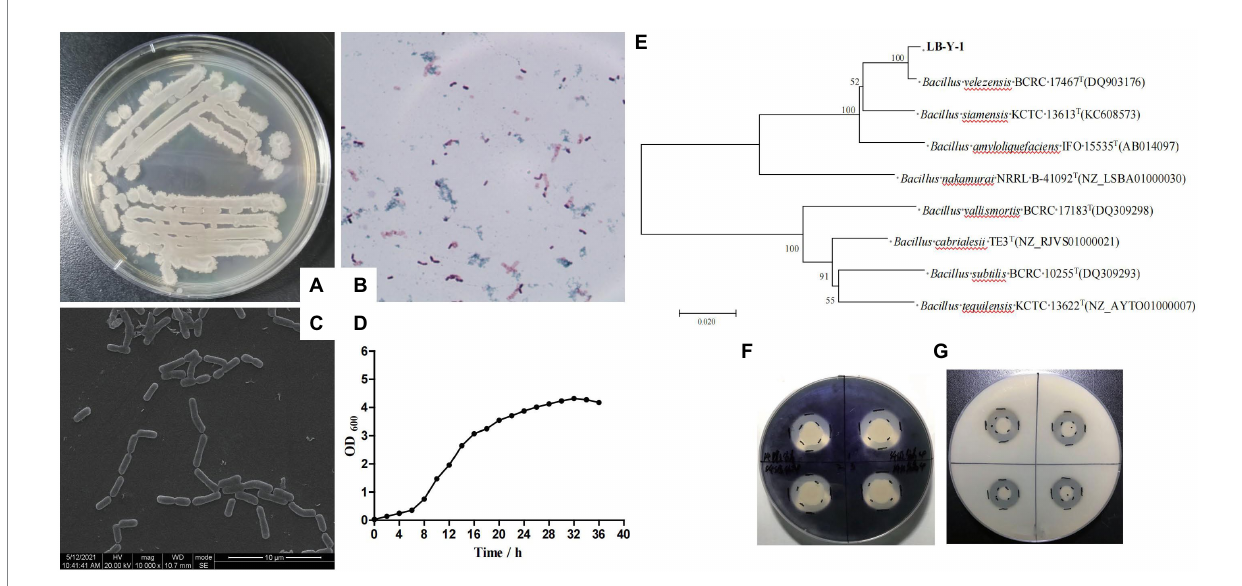
FIGURE 3 Morphological, biochemical, and molecular characteristics of LB-Y-1. (A) Colony morphology. (B) Gram stain showing Gram-positive rod. (C) SEM image of LB-Y-1 showing a small rods morphology, frequently in pairs or short chains (×1,000). (D) The growth curve of LB-Y-1. (E) The phylogenetic tree analysis of LB-Y-1. (F) Starch-degradation ability. (G) Triglyceride-degradation